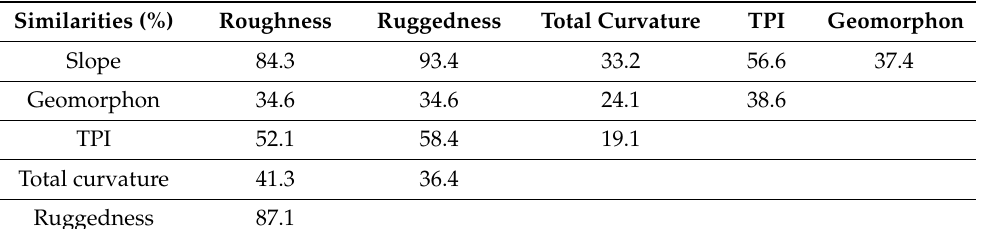
Table 4. Comparison of results of geodiversity assessment based on different geomorphological models evaluated with natural